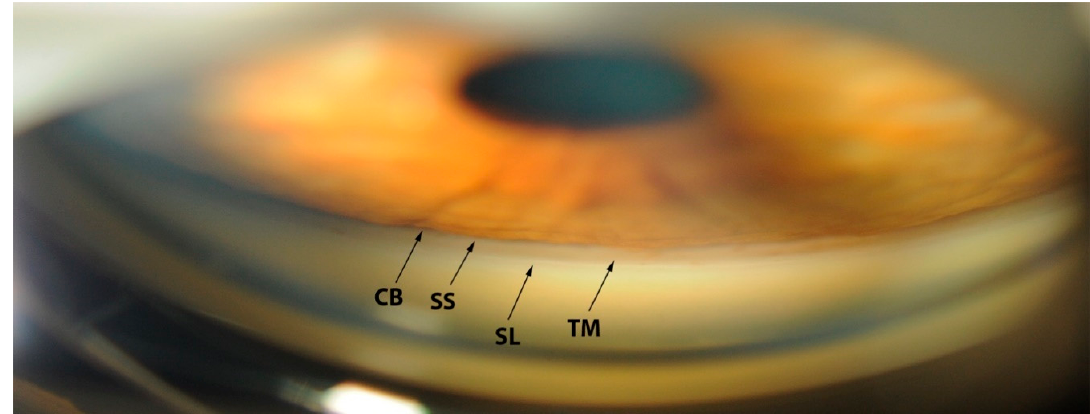
Figure 2. Gonioscopic image of the anterior chamber angle. SL: Schwalbe’s line; TM: Trabecular meshwork; SS: Scleral spur, CB: Ciliary body band .